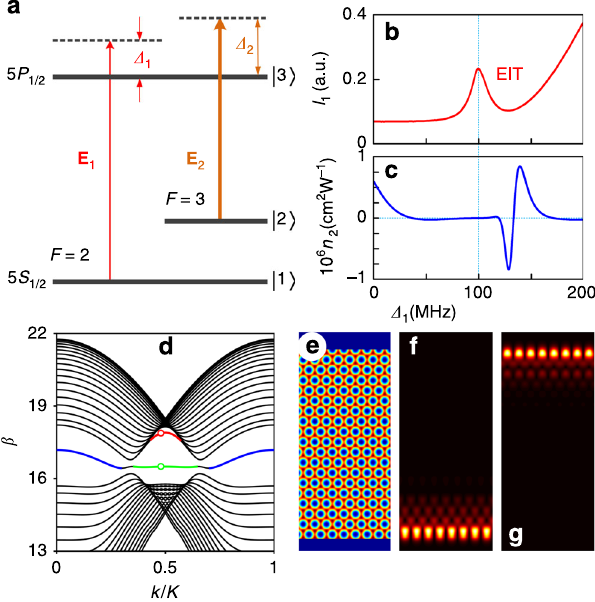
Fig. 1 Atomic energy levels, linear bandgap structure, and edge